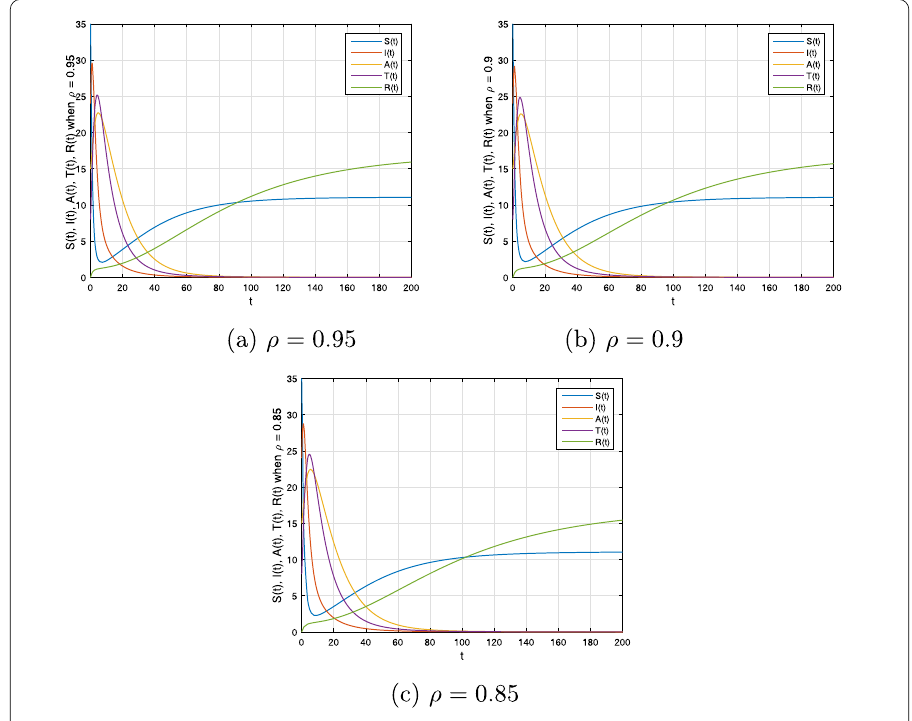
Figure 1 The time series plots for all state variables in model (11) when ( a ) ρ = 0.95, ( b ) ρ = 0.9, ( c ) ρ =